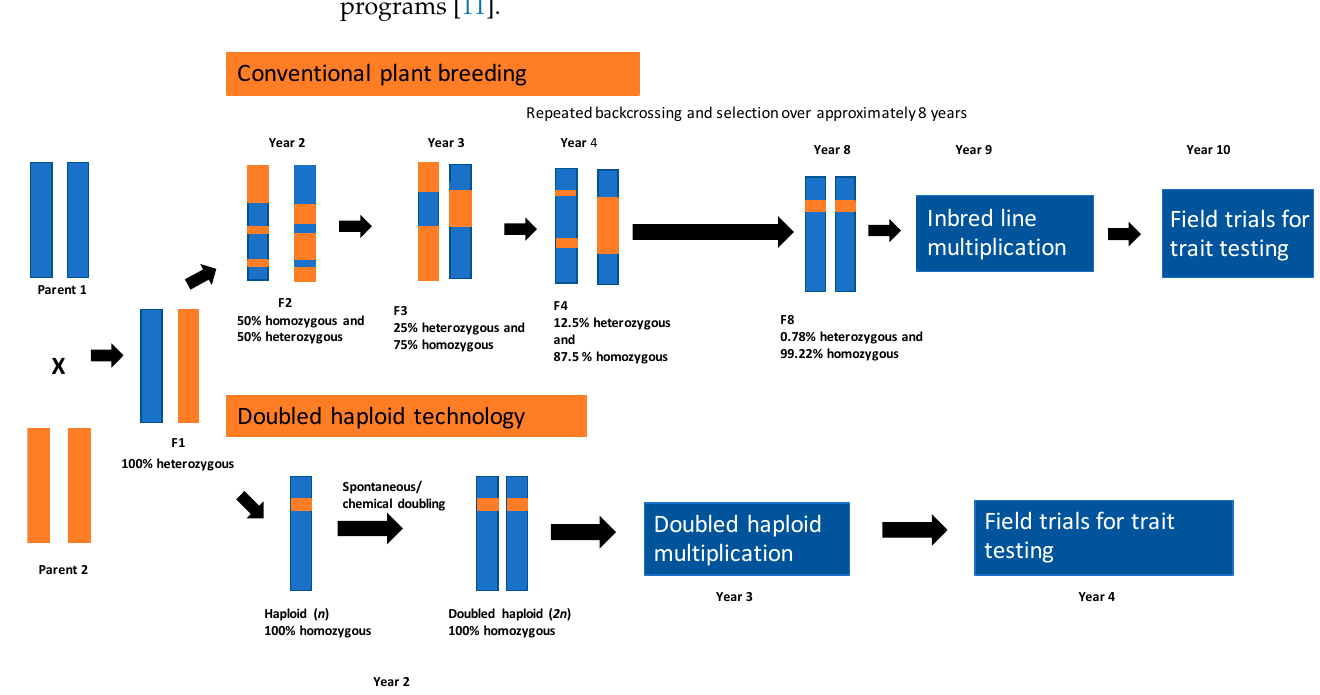
Figure 1. Comparison of conventional breeding and doubled haploid (‘accelerated breeding’) tech- nology breeding methods (Illustration adapted from [21] 2022).